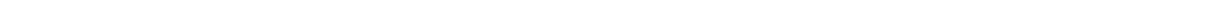
Figure 4 | The hBRM and BRG1 AT-hook and BRD form multivalent interactions with DNA. ( a ) EMSAs carried out with the hBRM (left) or BRG1 (centre) AT-BRD or BRG1 GST-AT-hook (right) and either 601 NCP (top) or free 601 DNA (bottom). Gels were run with a 100bp DNA ladder on the left and stained with ethidium bromide for visualization. ( b ) Overlay of 1 H- 15 N HSQC spectra for 15 N-hBRM (left two panels) or 15 N-BRG1 (right two panels) AT-BRD upon titration of DNAI or DNAII. The spectra are colour coded for protein:DNA molar ratio as shown in the legend. DNA titrations were collected at protein:DNA molar ratios of 1:0, 1:0.25, 1:0.5, 1:1, 1:1.5, 1:3, and 1:5-6. For clarity, only four points are displayed. The (*) marking indicates that the peak broadens beyond detection upon addition of DNA, and thus its trajectory cannot be followed. ( c ) Corresponding normalized CSPs for hBRM-B are plotted as a function of residue upon titration of DNAI or DNAII for the protein:DNA molar ratio of 1:5-6. Residues that broaden beyond detection upon addition of DNA are marked (***). The secondary structure of the BRD is denoted below the plots, and residues that are perturbed greater than the average plus two standard deviations after trimming off the top 10% of CSPs are labelled. A grey line marks this level of significance for each titration. A dashed grey line marks the level of significance when only BRD residues are used to calculate the average. (inset) Surface representation of hBRM BRD structure (PDB ID 2DAT) with residues that are significantly perturbed upon binding to DNAI coloured in purple. The AT-hook is drawn in for illustrative purposes. ( d ) Representative FA binding curves for the hBRM-B and BRG1 AT-BRD upon binding to fluorescein-labelled DNAI.FA, DNAII.FA, and DNAIII.FA. The final three data points were not included in the fit for DNAIII.FA because they are suggestive of a secondary process beyond simple one-site binding. ( e ) Table of dissociation constants for the hBRM and BRG1 AT-BRD binding to fluorescein-labelled DNAs, determined via FA. Shown are the average values over 3-4 replicates and the associated standard